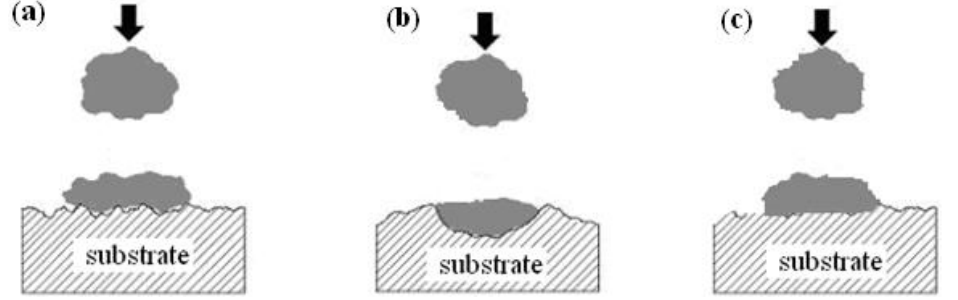
Figure 8. Scheme formation of titanium layer onto Al7075 substrate depending on nozzle distances from sample surface of: ( a ) 20 mm, ( b ) 70 mm, and ( c ) 100 mm.